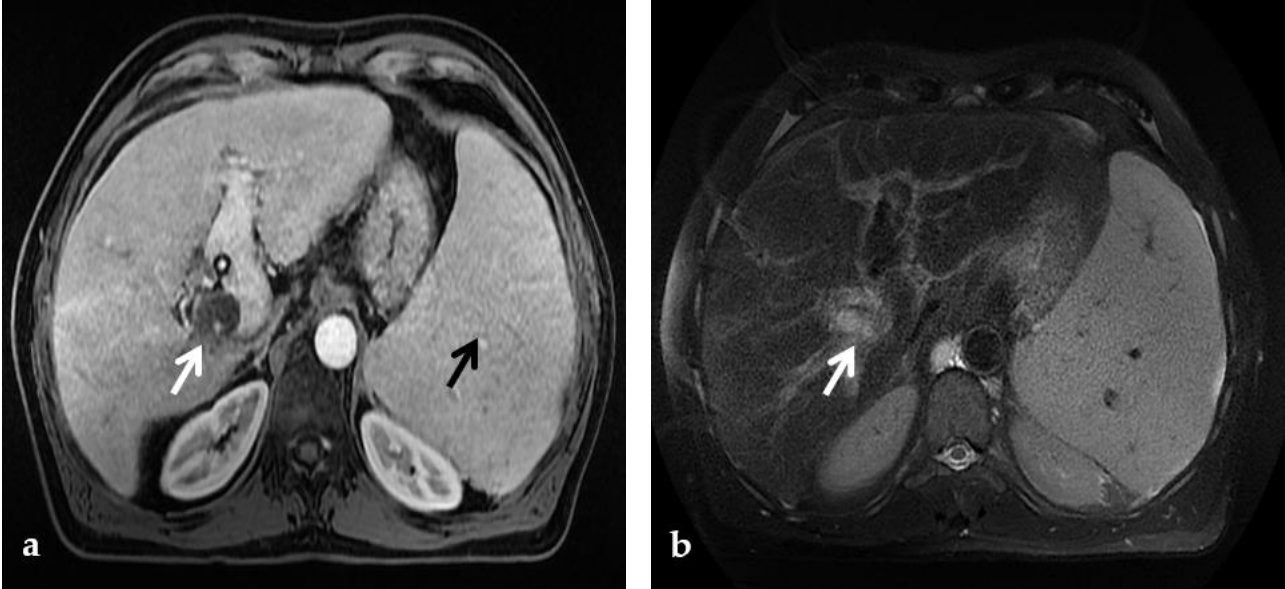
Figure 7. MR of a 50-year-old male with chronic portal vein thrombosis and portal hypertension. ( a ) Axial T1-weighted contrast-enhanced MR image shows low signal intensity within the right branch of the portal vein (arrow). Splenomegaly is a typical hallmark of portal hypertension (black arrow). ( b ) Axial T2-weighted MR image shows that portal vein thrombosis appears of increased signal intensity (arrow).